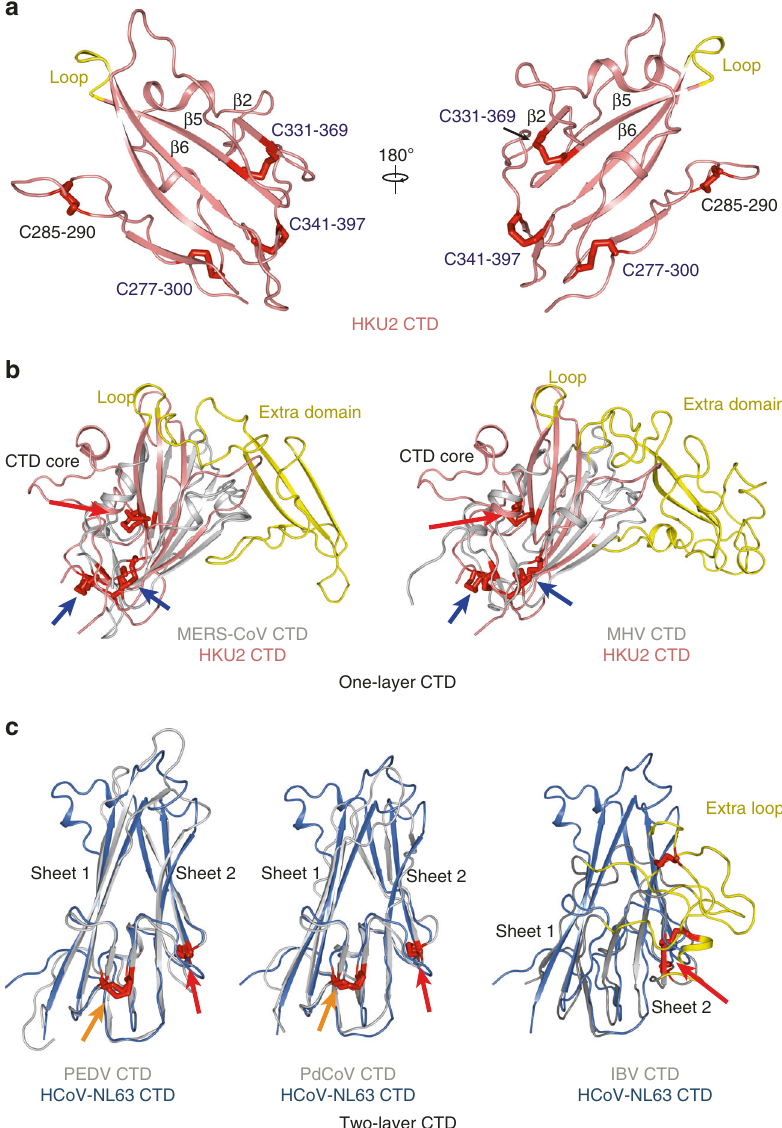
Fig. 3 Structure of HKU2 CTD and comparisons. a HKU2 CTD shown in two opposite directions. Strands mentioned in the main text are labeled. The loop replaced by extra domain in β -coronavirus CTDs is shown in yellow. Disul fi de bonds are shown as red sticks. Conserved disul fi de bonds are labeled blue; other disul fi de bonds are labeled black. b β -coronavirus CTDs belong to one-layer CTD. Structural alignments of HKU2 CTD with MERS-CoV CTD, and with MHV CTD are shown. Extra domains in β -coronavirus CTDs are colored yellow. Disul fi de bonds are shown as red sticks. Disul fi de bonds conserved in both one-layer CTD and two-layer CTD are indicated by red arrows. Disul fi de bonds only conserved in one-layer CTD are indicated by blue arrows. PDB codes: MHV, 3JCL; MERS-CoV, 6Q05. c α -coronavirus (except for HKU2 and SADS-CoV), γ -coronavirus, and δ -coronavirus CTDs belong to two-layer CTD. Structural alignments of HCoV-NL63 CTD with PEDV CTD, with PdCoV CTD, and with IBV CTD are shown. Two layers of β -sheets are labeled. Extra loops in IBV CTD are colored yellow. Disul fi de bonds are shown as red sticks. Disul fi de bonds conserved in both one-layer CTD and two-layer CTD are indicated by red arrows. Disul fi de bonds only conserved in two-layer CTD are indicated by orange arrows. PDB codes: HCoV-NL63, 5SZS; PEDV, 6U7K; IBV, 6CV0; PdCoV, short strand (713 – 716) and the third helix is replaced by a loop dissociation of the S1 subunit triggered by receptor binding, the (721 – 741), therefore there are two short strands and only one exposure of the S2 ′ site for cleavage is a prerequisite for the helix in HKU2 CR (Fig. 6c). The conserved disul fi de bond proteolytic activation of the coronavirus spike to mediate C 696 – C 706 makes the fi rst helix of CR in HKU2 spike turn upside membrane fusion. The buried S2 ′ site indicates that HKU2 spike, down. The S2 ′ cleavage site (between R671 and S672) is then compared with other coronavirus spikes, would require more covered by the reversed CR helix and loops, and R671 interacts conformational changes around the S2 ′ site for the exposure. with E723 in the loop and K697 and K698 in helix 1 (Fig. 6c). In other coronaviruses, taking the MHV S2 for example, the helix 1 does not cover the S2 ′ site (between R869 and S870), and R869 only loosely interacts with T929 in helix 3 (Fig. 6b). After the PEAV in other reports) was recently identi fi ed from suckling